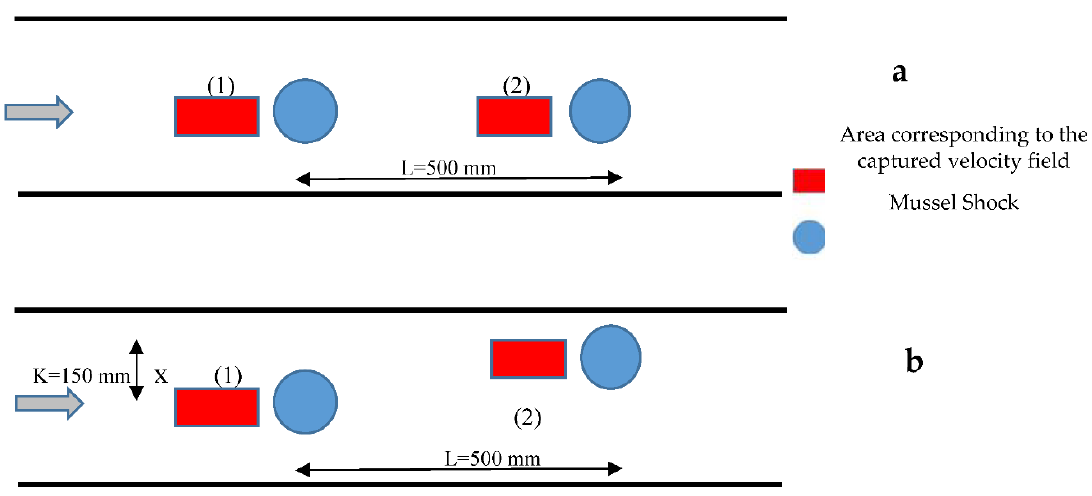
Figure 1. Mussel shocks and the area for the description of the velocity field in front of two successive mussel shocks. ( a ) corresponds to the case with the shocks on the central axis of the channel, while ( b ) corresponds to the case where the line connecting the two shocks forms an angle with the central axis of the channel.